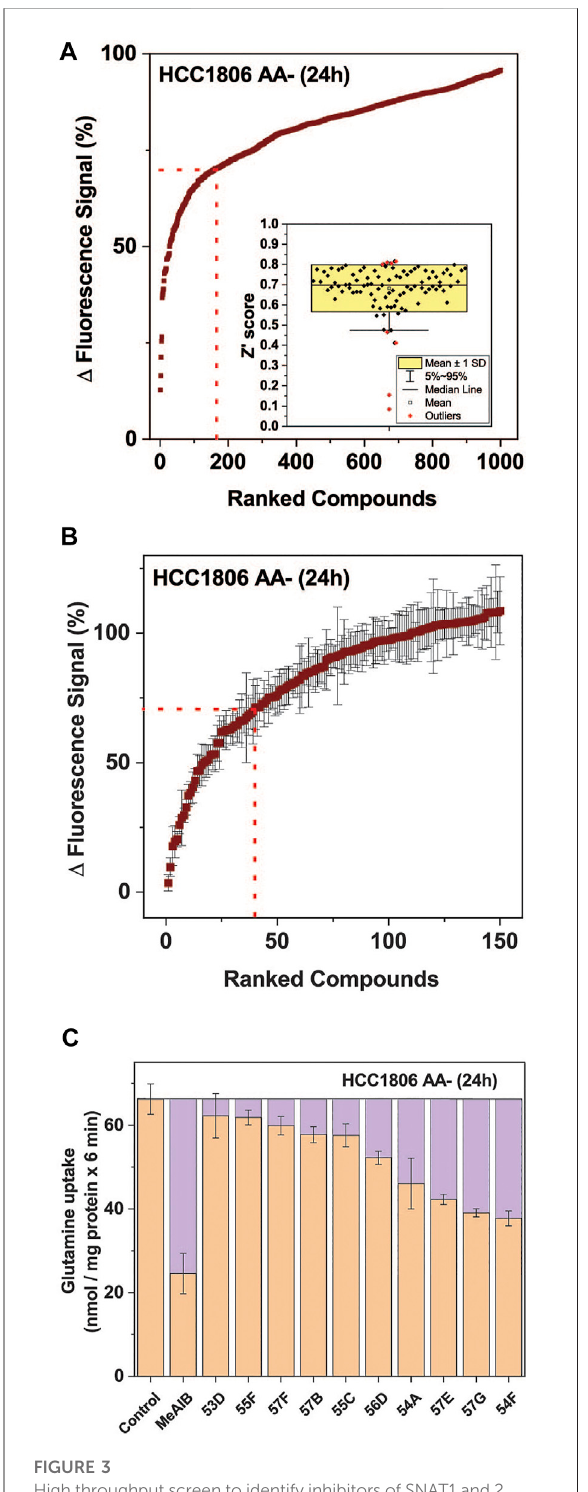
FIGURE 3 High throughput screen to identify inhibitors of SNAT1 and 2.